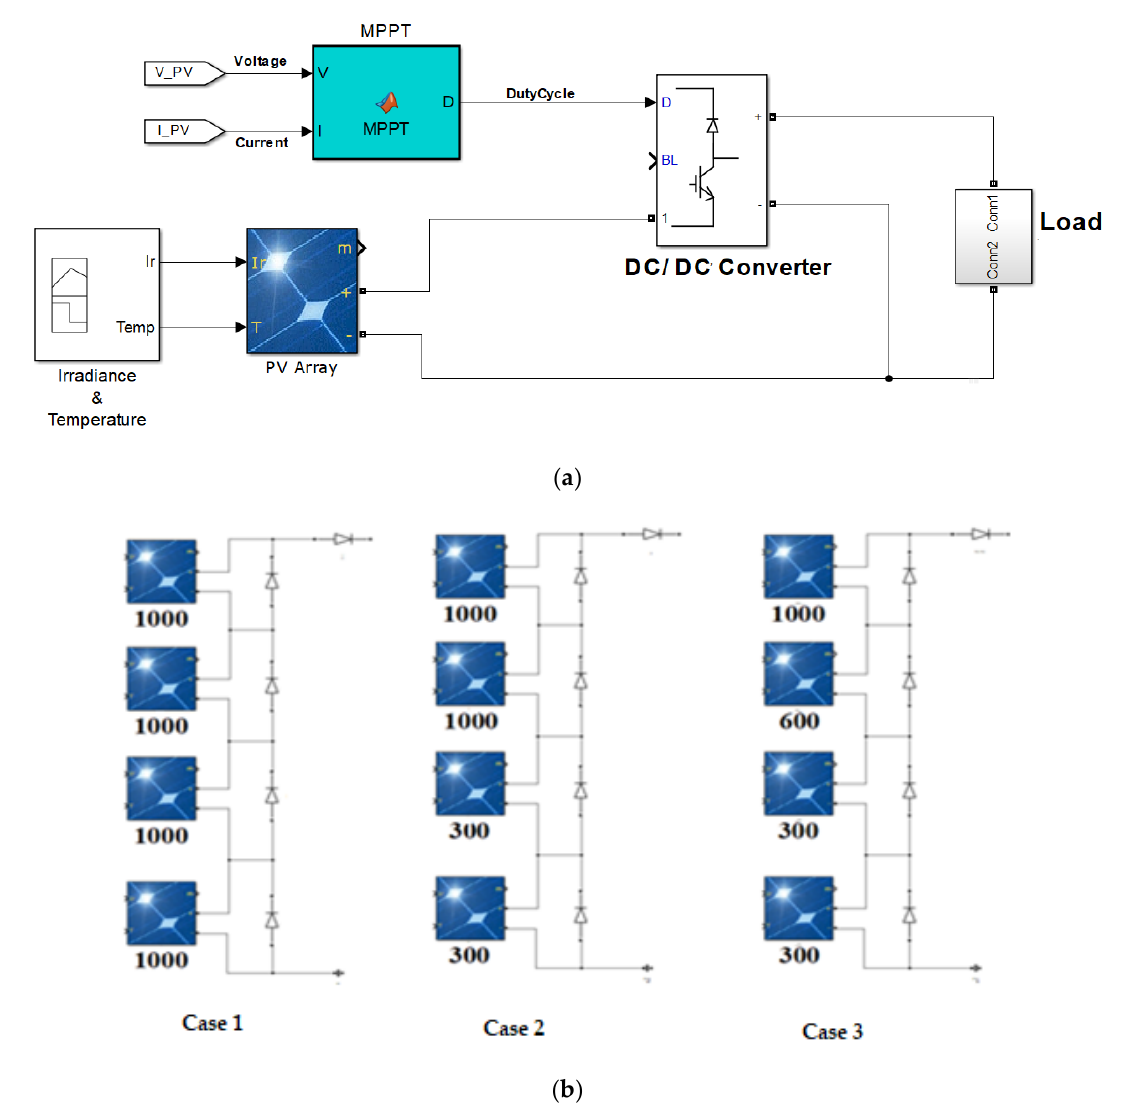
Figure 4. The 4S standalone solar photovoltaic testing system: ( a ) standalone photovoltaic system; ( b ) 4S PV array under zero, weak, and strong PSC. Table 2. Tuning parameters of OTCA and TCA algorithms.